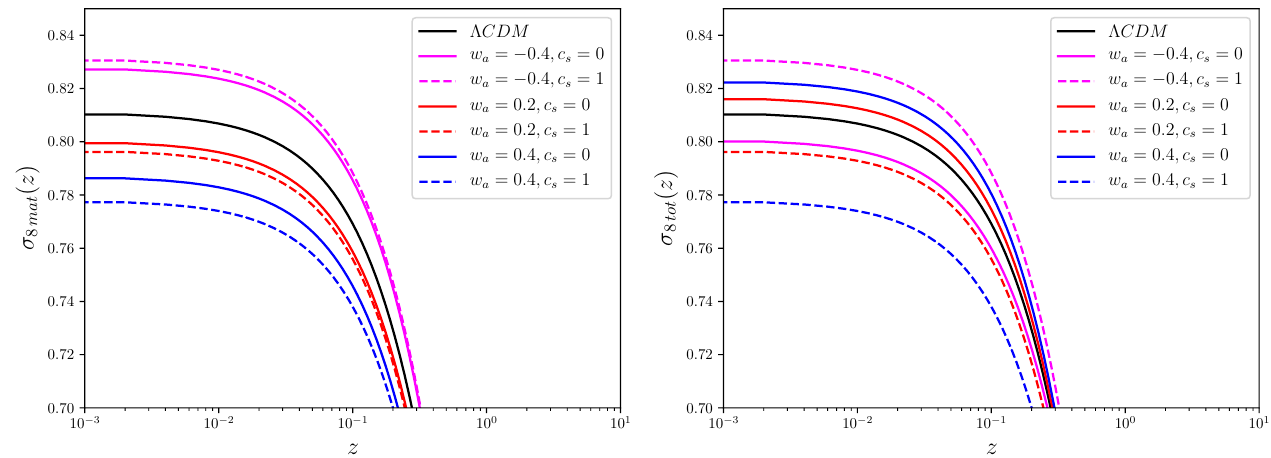
Figure 7. Redshift evolution of σ 8 ( z ) for various DE models indicated in the legends. In the left panel : the growth function is given only by the matter perturbation. Right panel : the growth function is computed including the CDE contribution given by